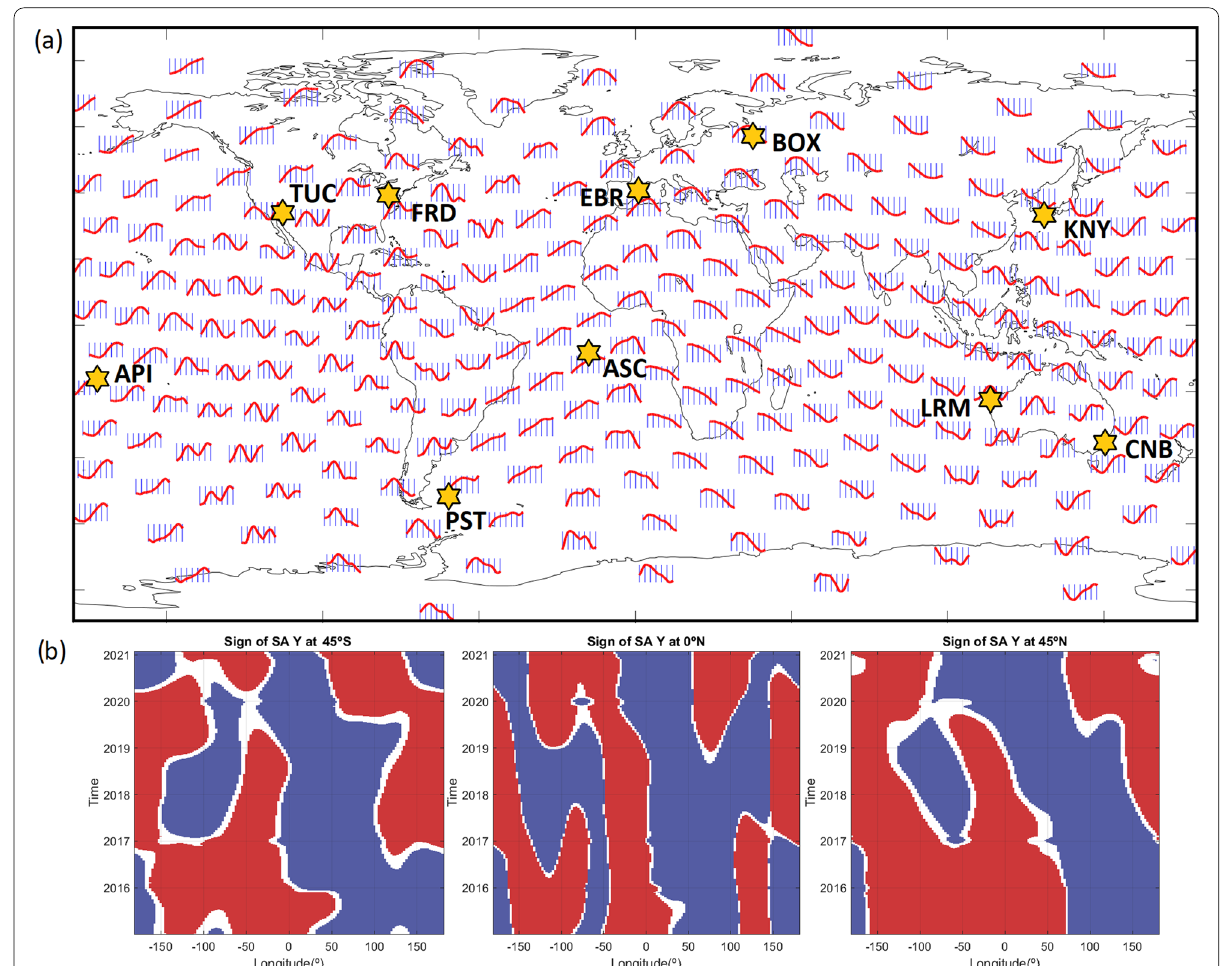
Fig. 3 a SV of the Y‑component from CHAOS‑7.7 at different locations at the Earth’s surface from 2015 to 2021 (a vertical blue line for each year is also plotted). b Hovmöller diagrams showing the sign of the SA of the Y ‑component at three different latitude profiles (45º S, equator and 45º N). Red colour indicates positive values of SA (increasing trend in the SV), blue indicates negative values of SA (decreasing trend in the SV) and white corresponds to null SA (maximum or minimum in the SV). Yellow stars in a) show the location of the 10 selected observatories labelled by